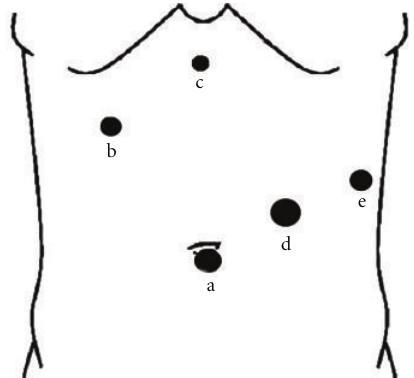
Figure 3: Port positions. A 10-mm umbilical port for laparoscopy (a), a 10mm on the right upper quadrant below the right costal margin on the midclavicular line (b), a 5mm trocar in the sub- xiphoid region (c), a 12mm trocar paraumbilical in the left mid- clavicular line (d) and a 10mm trocar in the left midaxillary line